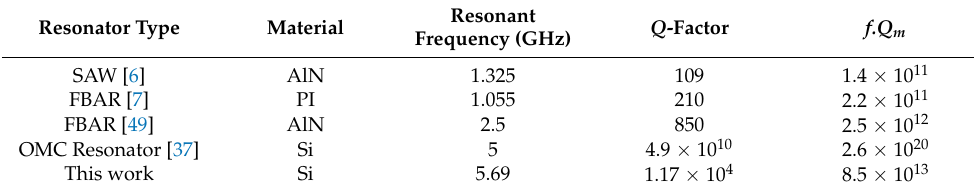
Table 2. A performance comparison among different types of resonators operating at GHz.